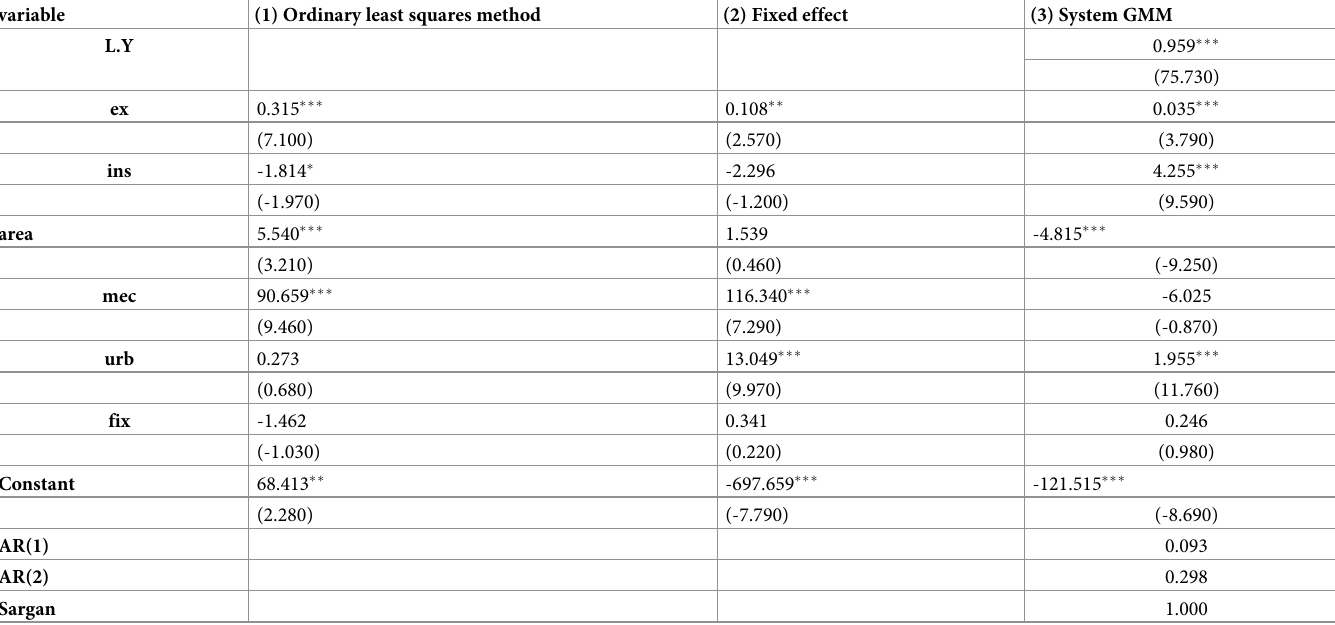
Table 6. The static and dynamic model test results of the indirect mechanism of agricultural insurance on farmers’ income.